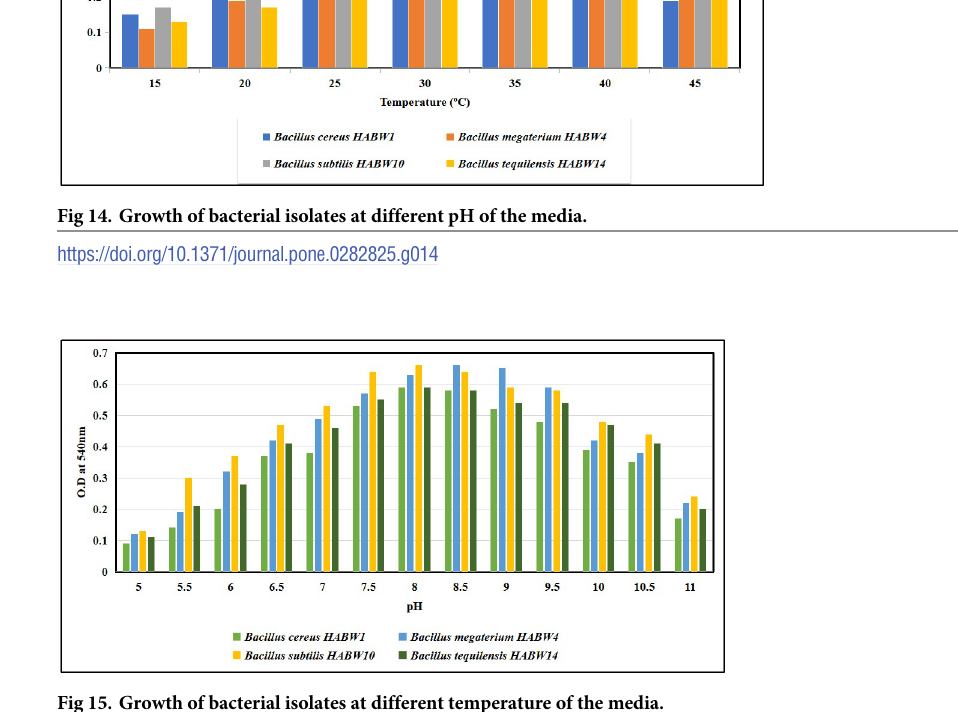
Fig 15. Growth of bacterial isolates at different temperature of the